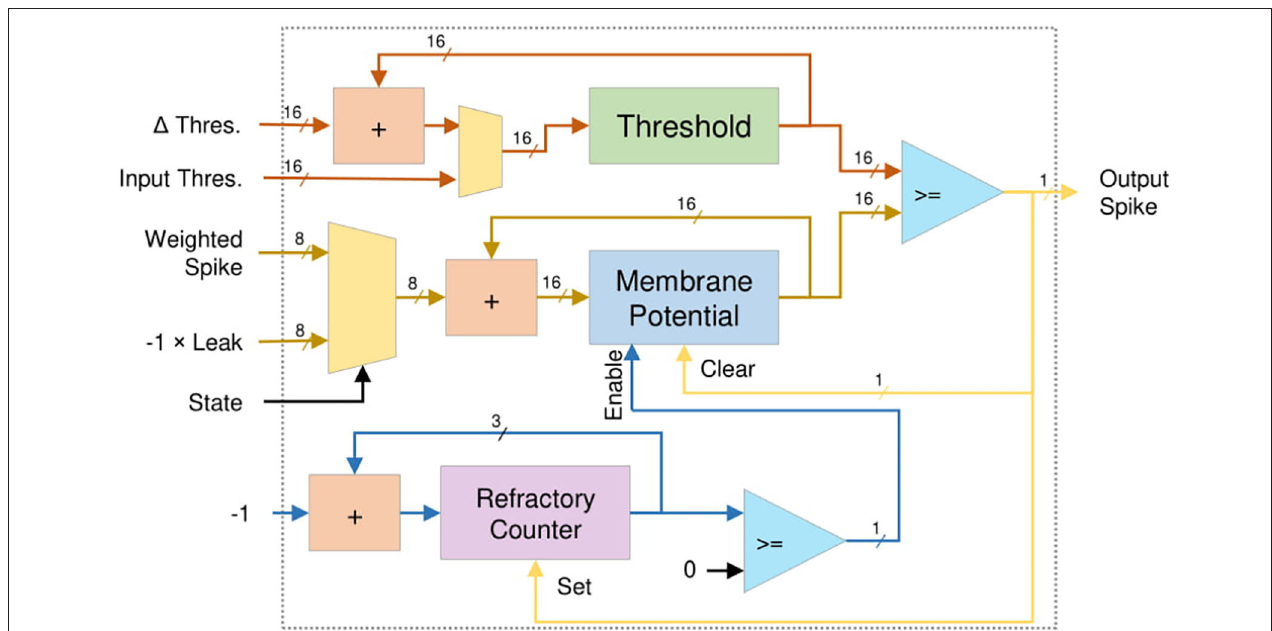
FIGURE 5 | Temporal lif neuron model